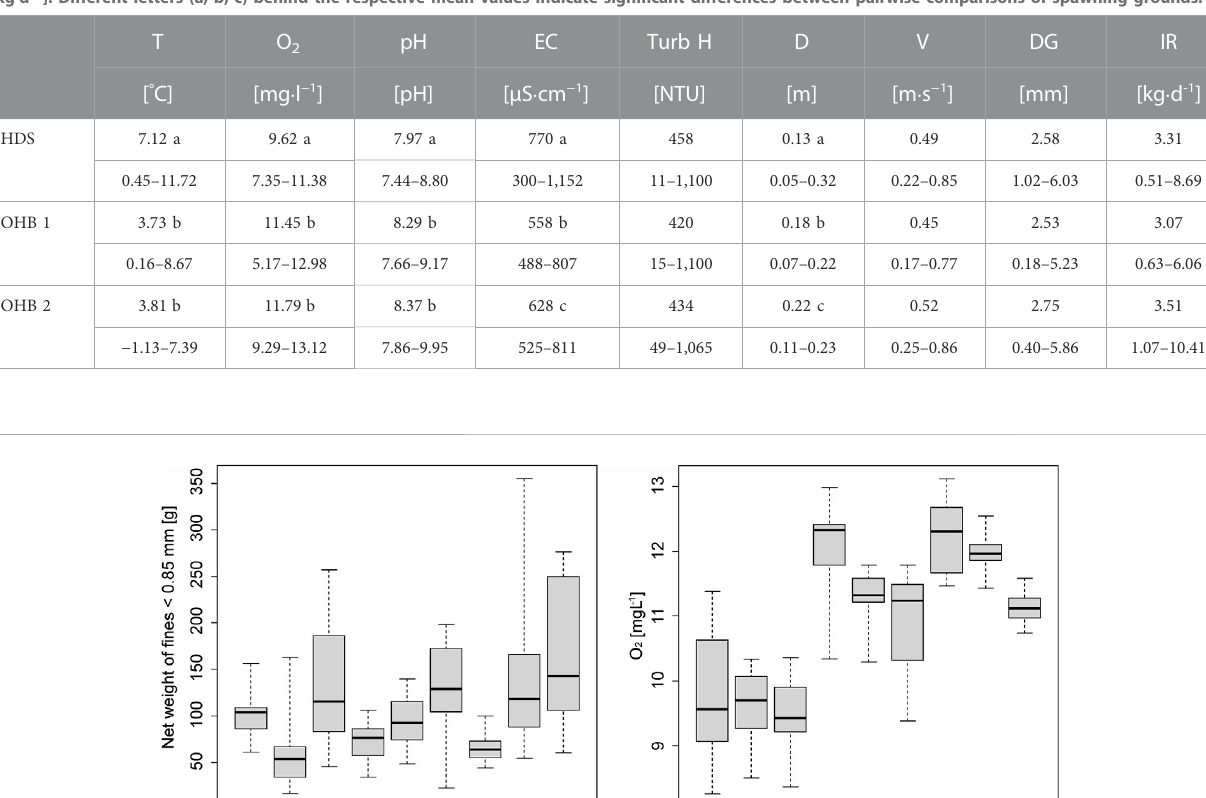
TABLE 5 Abiotic spawning ground characteristics of the assessed Ottheinrichbach (OHB) and the groundwater-in fl uenced hinterland draining system Längenmühlbach (HDS). T, temperature; O 2 , dissolved oxygen [mg · L − 1 ]; pH, pH-value; EC, electric conductance [µS · cm − 1 ]; Turb H, turbidity [NTU] measured in the HESTs compartments; D, water depth [m]; V, riverbed velocity [m · s − 1 ]; DG, mean particle diameter after retrieving the HESTs [mm]; IR, sediment in fi ltration rate [kg · d − 1 ]. Different letters (a, b, c) behind the respective mean values indicate signi fi cant differences between pairwise comparisons of spawning grounds.